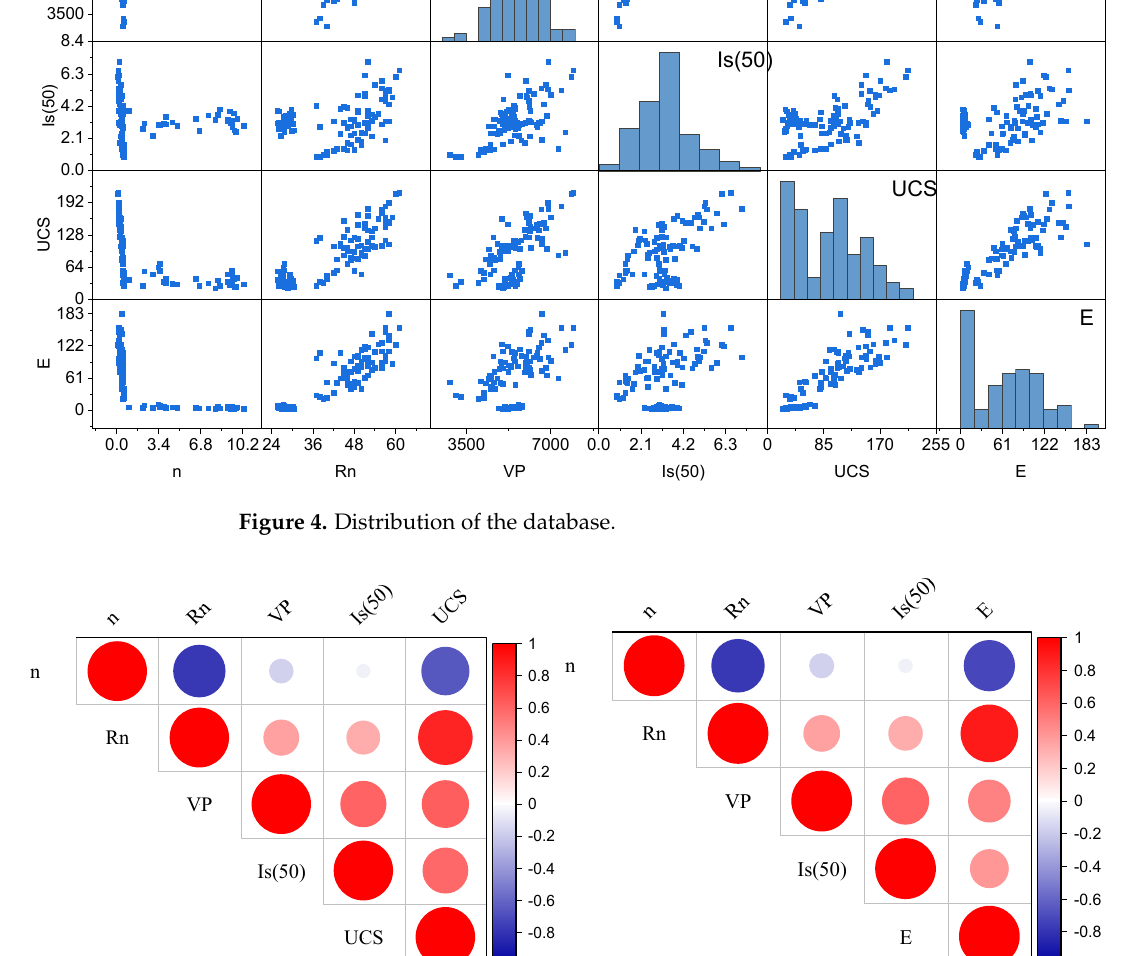
Figure 5. Correlation coefficients between variables. Table 1. Mathematical statistical characteristics of the